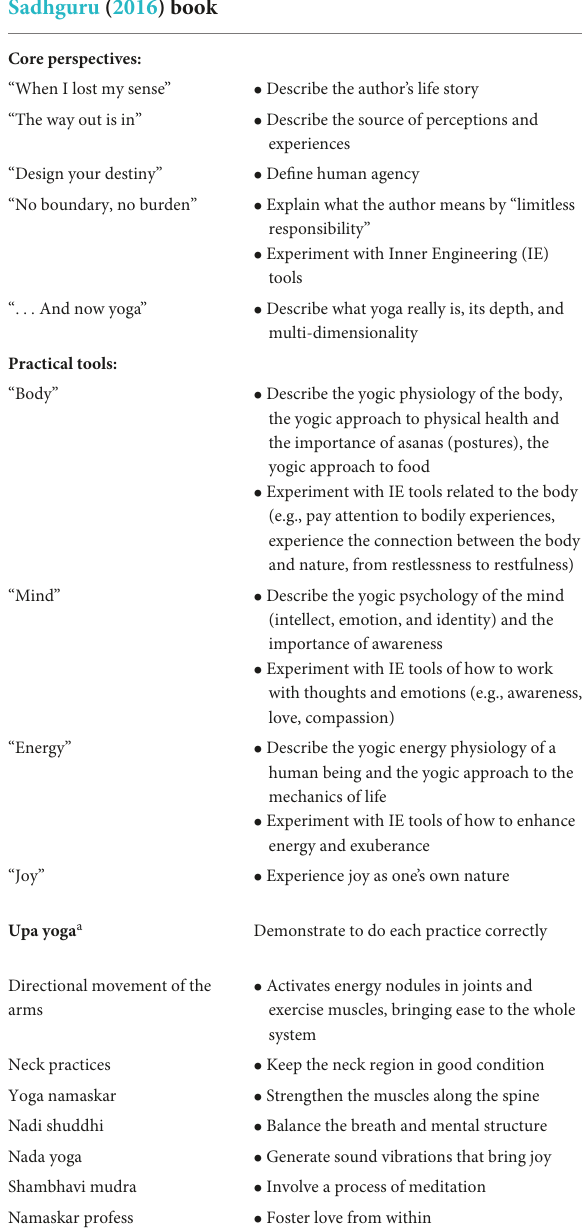
TABLE 1 Course components and learning